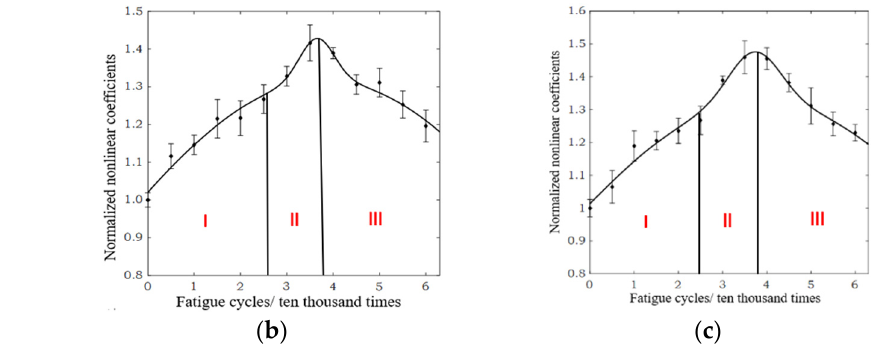
Figure 8. Three stages of the normalized ultrasonic nonlinear coefficients–fatigue cycles curve. ( a ) Specimen B1. ( b ) Specimen B2. ( c ) Specimen B3.